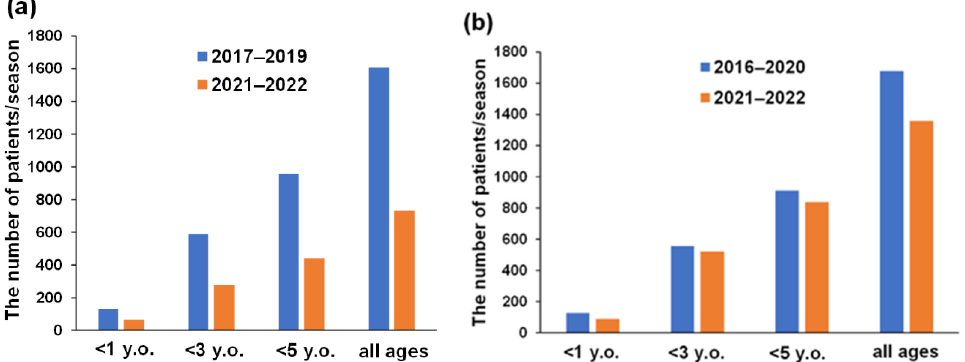
Figure 2. The number of patients aged < 1 year, 1–<3 years, 3–< 5 years, and all ages per RV and NV seasons pre- and post-RVV NIP. The number of patients aged <1 year, 1–<3 years, 3–<5 years, and ≥ 3 years all ages per ( a ) RV seasons and ( b ) NV seasons pre- and post-RVV NIP. The vertical axis indicates the number of patients with AGE per season (( a ) the number of patients with AGE divided by three (2017, 2018, and 2019) and two (2020 and 2021); ( b ) the number of patients with